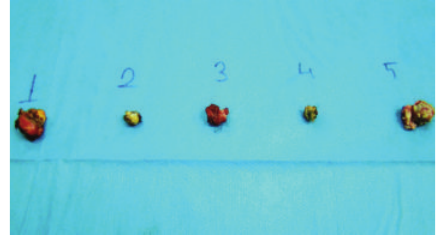
Figure 6: The all pathological lesions after